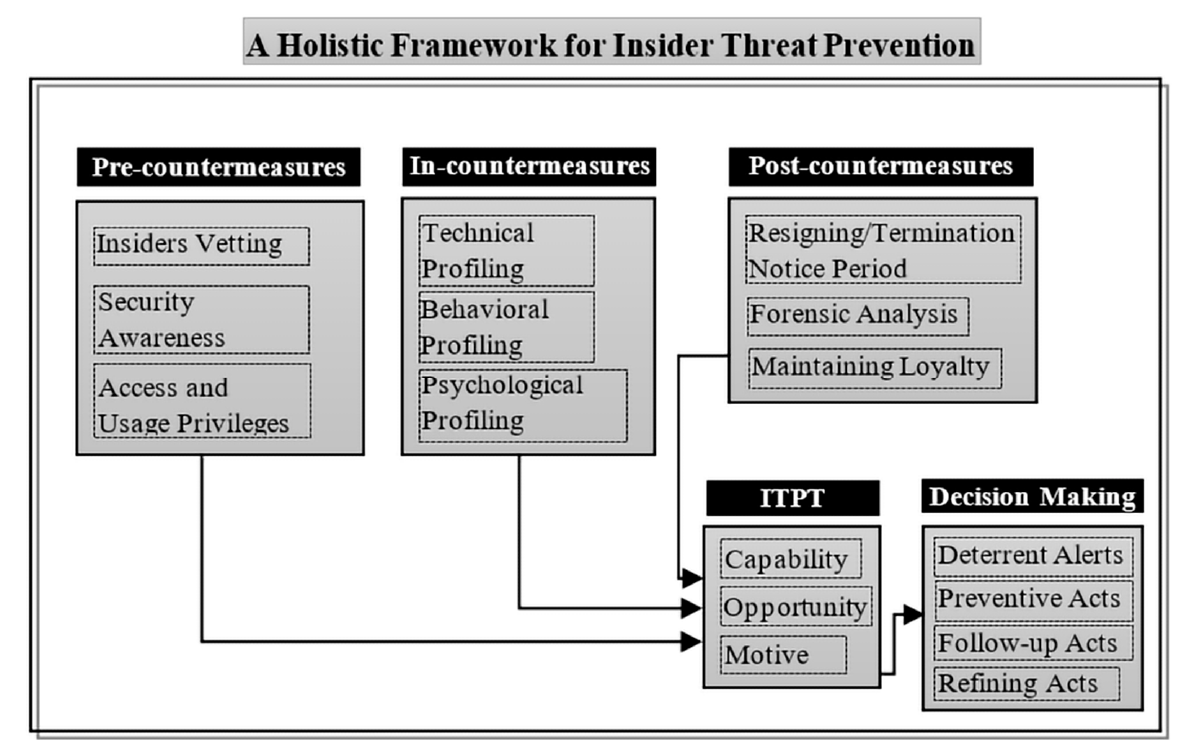
Figure 2. Insider threat prevention framework.